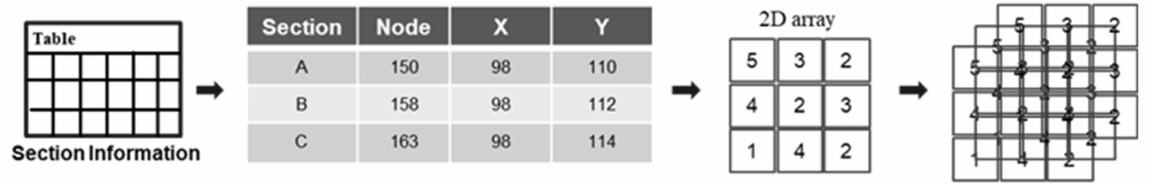
Figure 4. Conversion of logistic data into